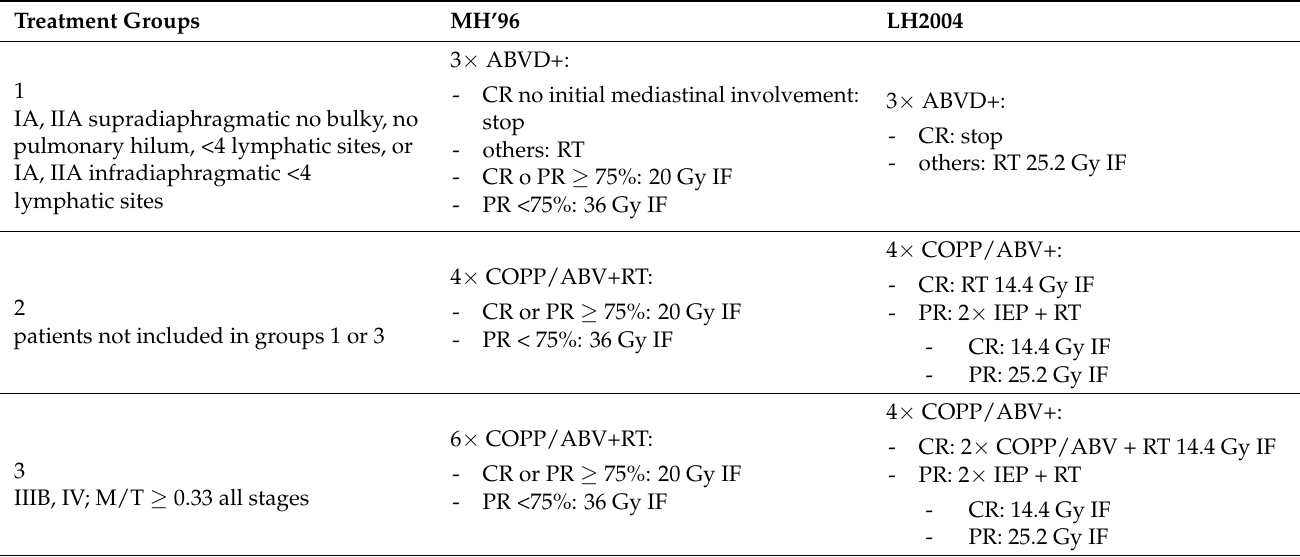
Table 1. Summary of MH96 and LH2004 AIEOP